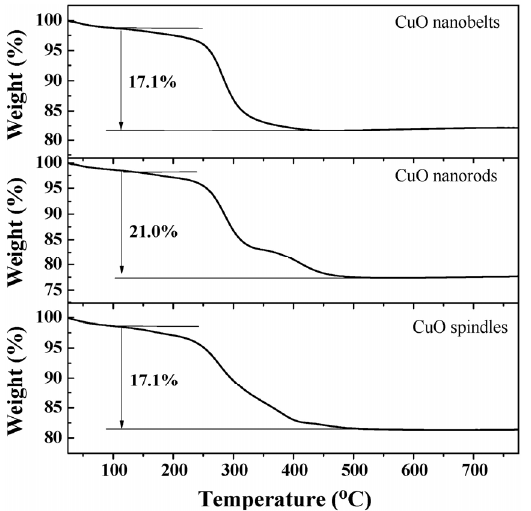
Fig. 7 TGA curves of CuO nanostructures with different mor- phologies under N 2 atmosphere at a heating rate of 10